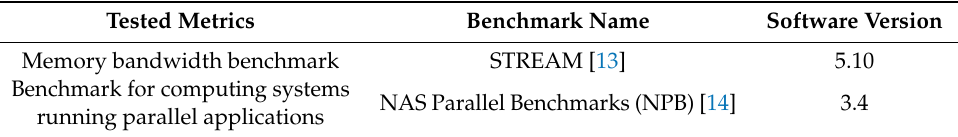
Table 3. List of used